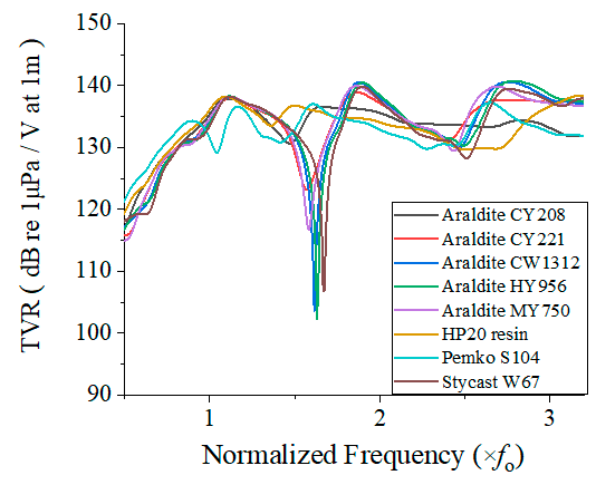
Figure 5. TVR spectra of the array potted with epoxy materials. The TVR spectra were significantly different from each other, implying a significant difference in the effect of each material. Five relatively stiffer materials (Araldite CW1312, CY221, HY956, MY750, and Stycast W67) caused clear harmonics of the fundamental mode